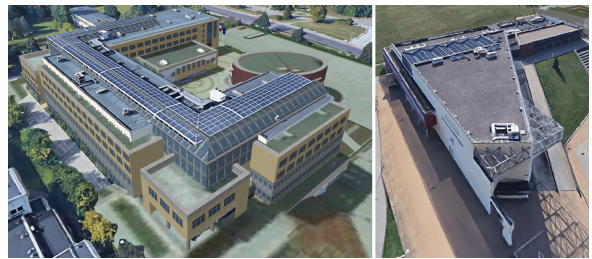
Figure 2. Sketchup 3D models of test